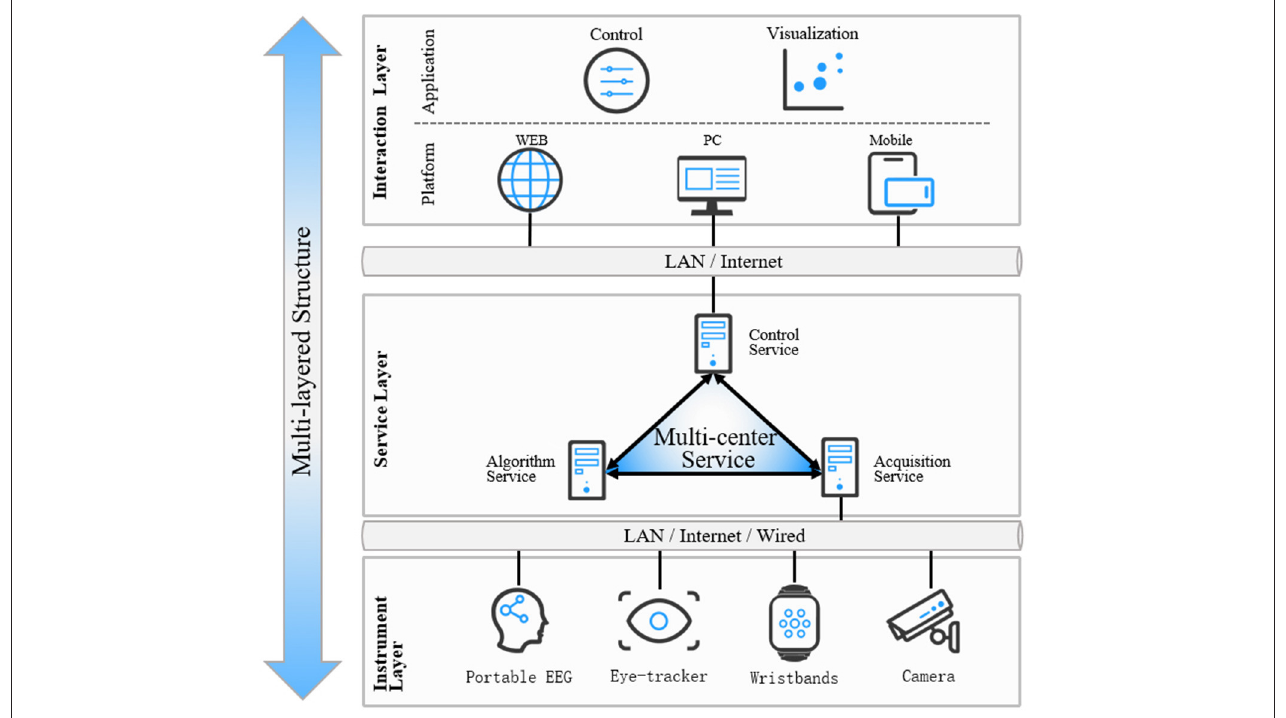
FIGURE 1 | The MCAC framework